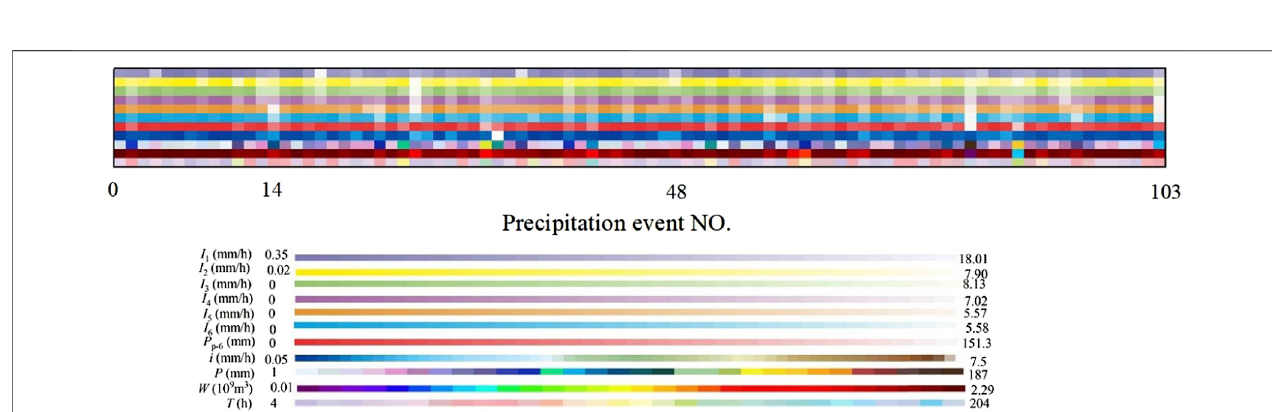
FIGURE2 | Values ofsub-rainfall event characteristic factors, 1 – 103 are thenumbers of sub-rainfall events. I 1 isthe maximum 1 h rain intensity; I 2 − 1 is thesecond- largest hourly rainfall intensity; Similarly, I 3 − 2 , I 4 − 3 , I 5 − 4 , and I 6 − 5 are the 3rd, 4th, 5th, and 6th largest hourly rainfall intensity, respectively; P p-6 is the rainfall minus the maximum rainfall of 6 h; P is the rainfall; W is the fl ood amount yielded by sub-rainfall; T is the sub-rainfall duration.